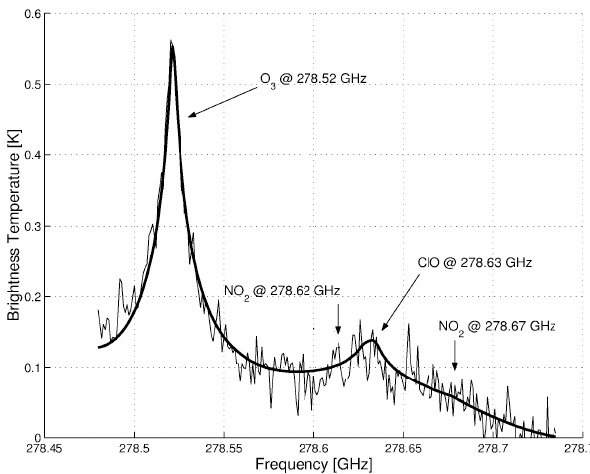
Fig. 1. Stratospheric brightness temperature from the zenith direc- tion for a measured spectrum averaged over 1995 (thick line) and a 15-min. integration spectrum measured on 5 January 1995 (thin line). Contributions from O 3 , ClO and NO 2 are quoted. Only the 1- MHz channels are shown. Baseline ripples are not subtracted from the